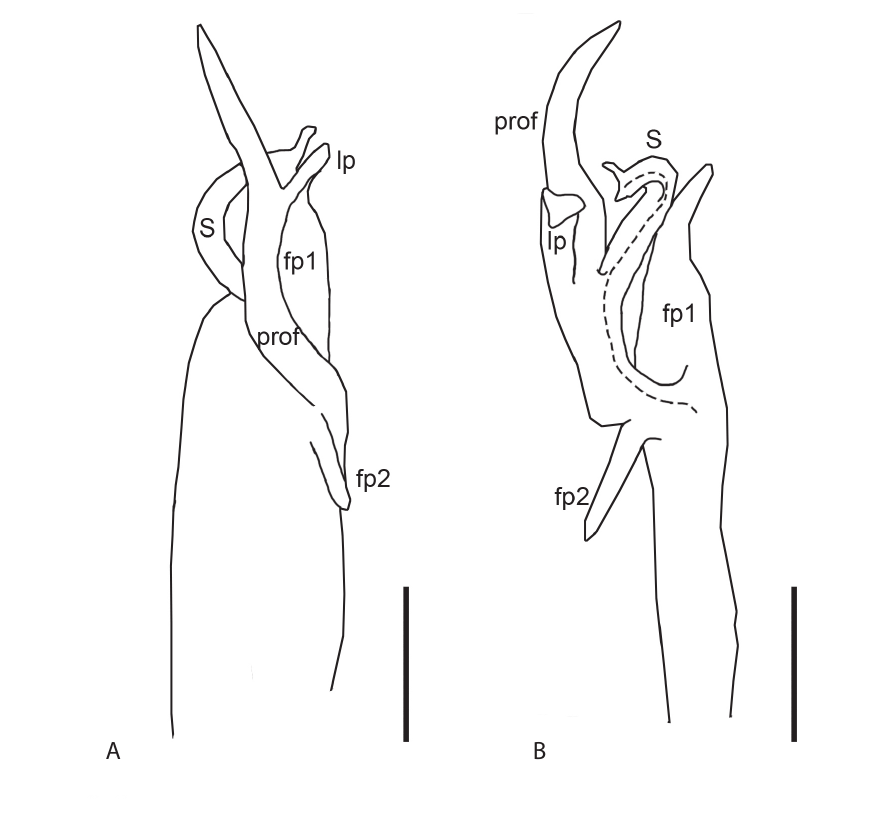
Fig. 24. Pogonosternum montanum Decker, sp. nov., ♂, paratype from Mt Beauty, right gonopod (AMS KS106738). A . Posterior view. B . Mesal view. Abbreviations: see Material and methods. Scale bars: 0.5 mm.